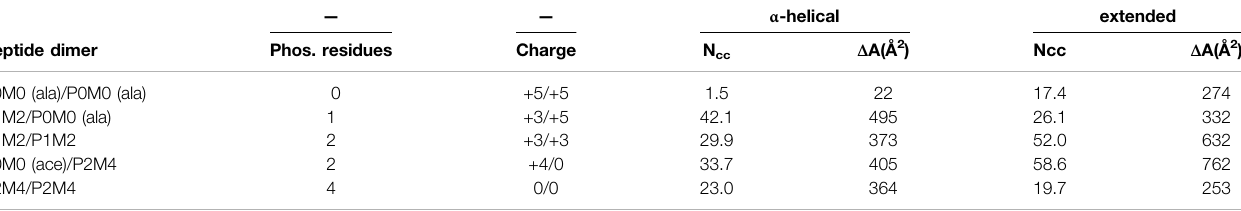
TABLE 2 | Close contacts and change in solvent-accessible surface area upon peptide interaction. — — α -helical extended Peptide dimer Phos. residues Charge N cc Δ A(Å 2 ) Ncc Δ A(Å 2 ) P0M0 (ala)/P0M0 (ala) 0